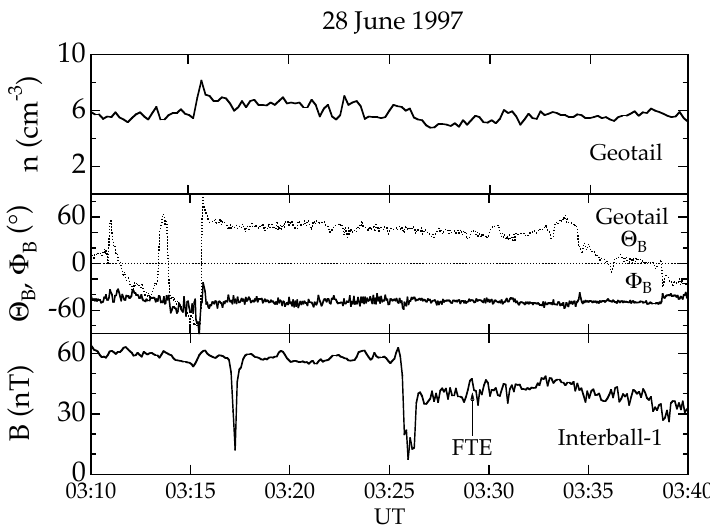
Fig. 3. A comparison of Geotail magnetosheath observations with Interball-1 observations of the magnetopause crossing on 28 June 1997. From top to bottom, the panels in the figure show: Geotail density observations, Geotail magnetic field latitude and longitude observations in GSM coordinates, and Interball-1 magnetic field strength observations.